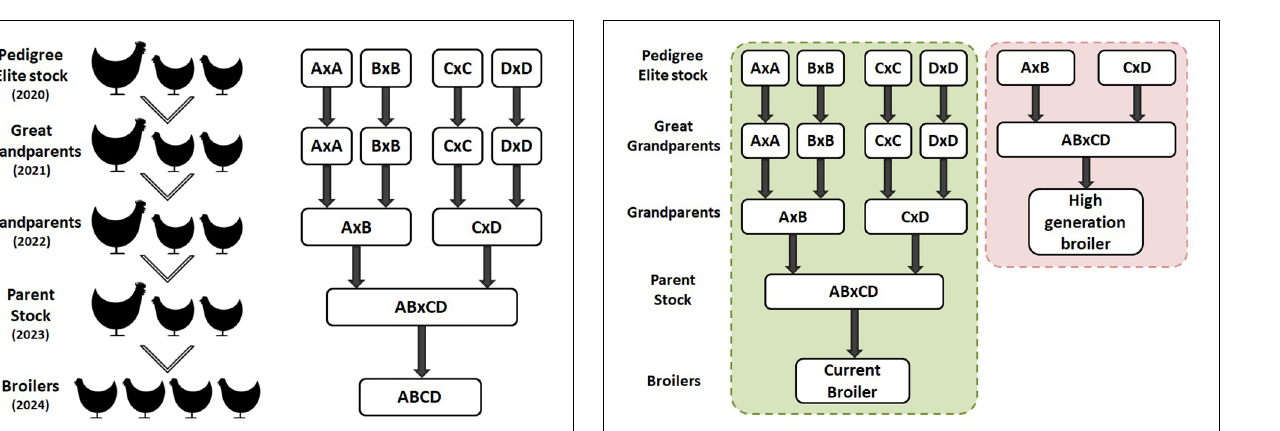
FIGURE 3 | The commercial broiler is a four way cross of pure broiler lines (represented by A, B, C, and D) as demonstrated in this image. The movement of genetic material from the pedigree pure lines to the commercial broiler population takes around 4 years through great grandparent, grandparent, and parent multiplier flocks, i.e. the impact of any genetic selection made in 2020 will reach the broiler population in 2024.